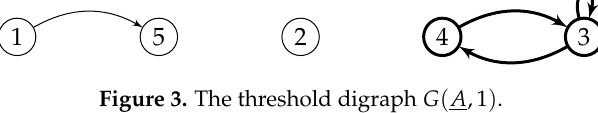
Figure 3. The threshold digraph G ( A ,1 ) .